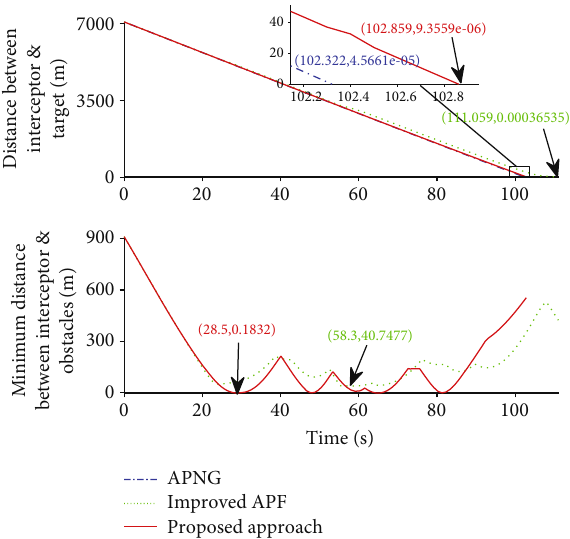
Figure 21: Changes of two distances in case 4.